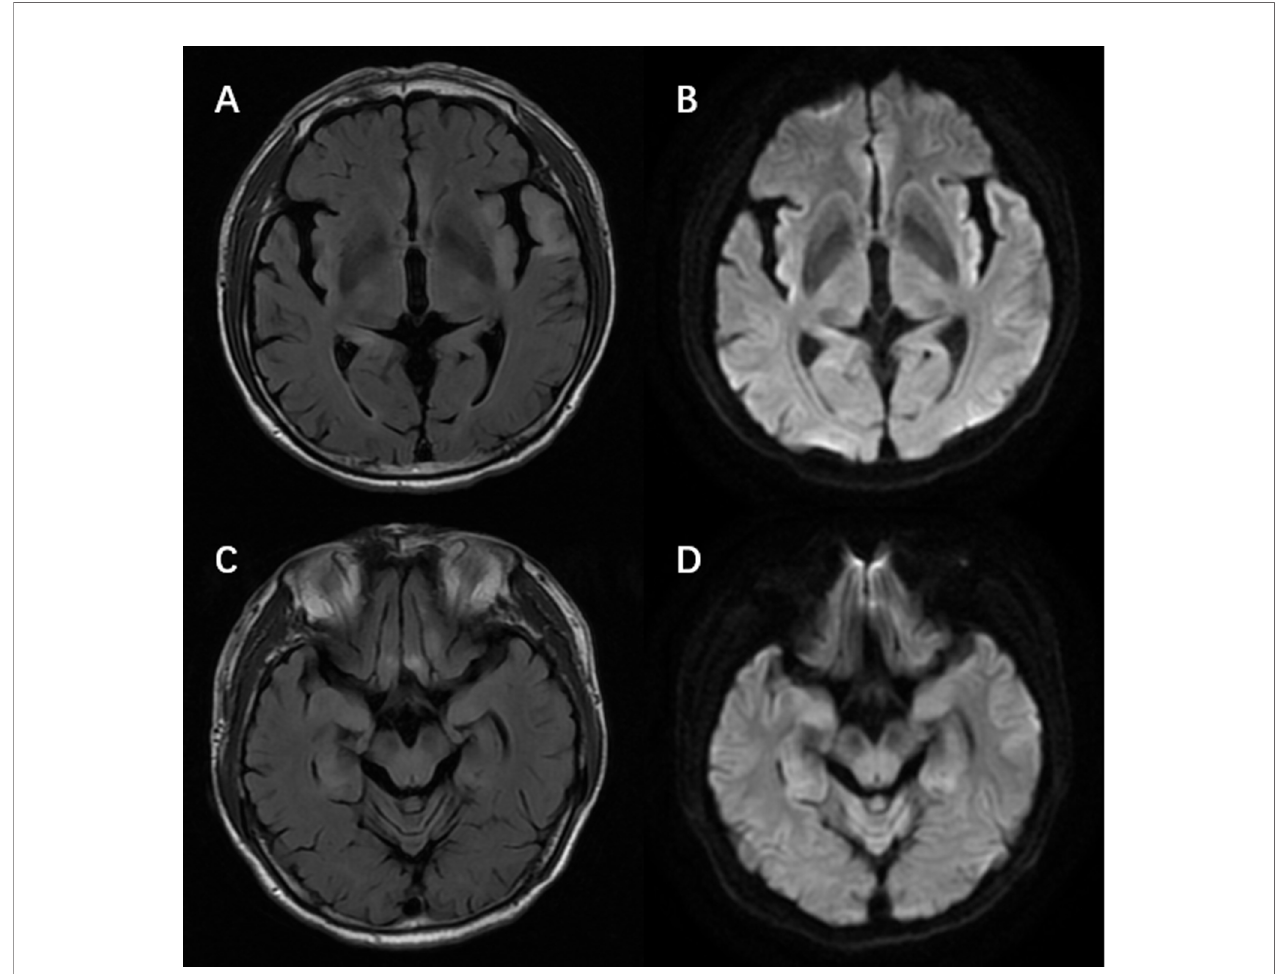
FIGURE 2 | Magnetic resonance imaging of a patient with anti-alpha-amino-3-hydroxy-5-methyl-4-isoxazolepropionic acid receptor encephalitis showed T2/ fl uid- attenuated inversion-recovery sequency hyperintensity in left temporal lobe, bilateral hippocampus, frontal lobes, insula (A, C) with restricted diffusion on diffusion weight imaging at the corresponding region (B, D) .